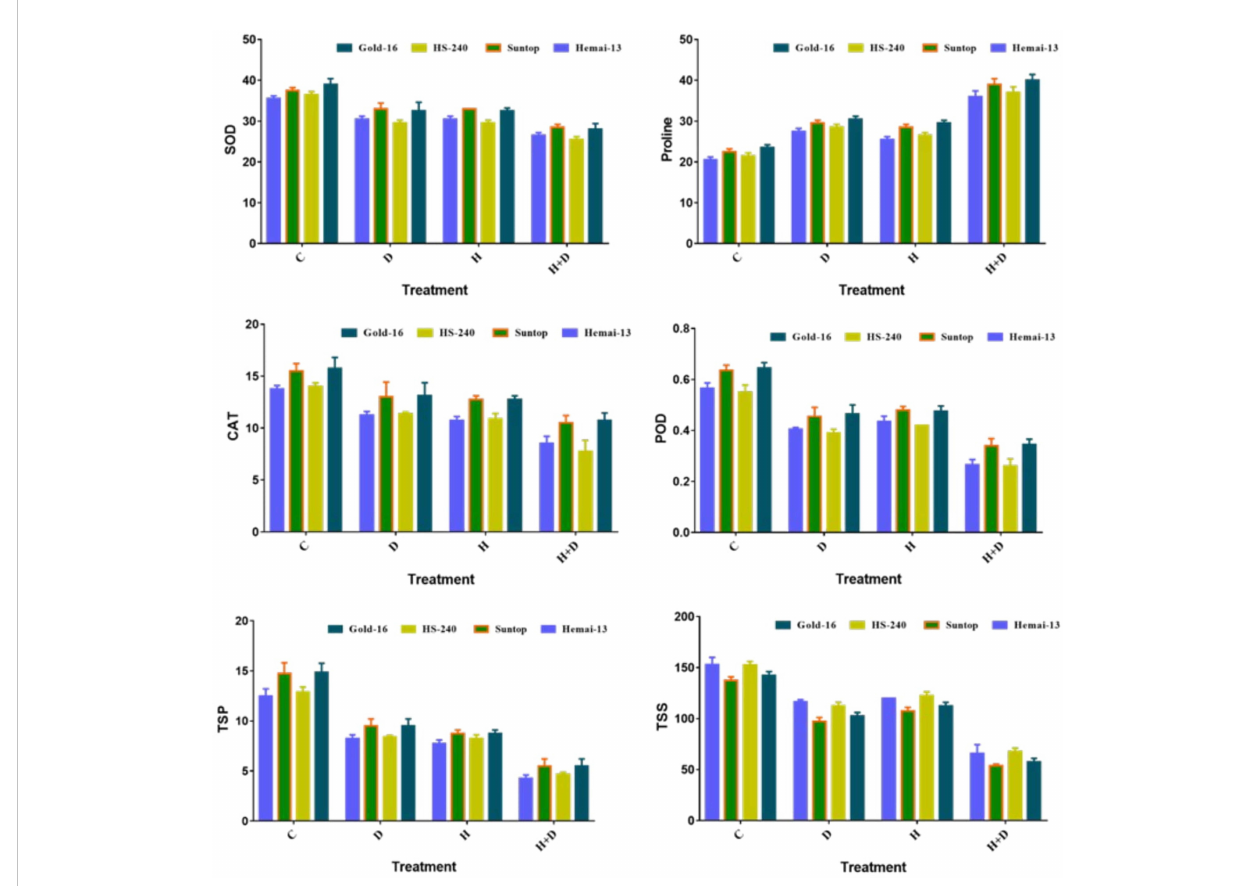
FIGURE 1 Variation in biochemical contents of wheat cultivars due to individual and combined treatments of drought and heat stress. Dry weight (DW); fresh weight (FW); superoxide dismutase (SOD); catalase (CAT); peroxidase (POD); total soluble proteins (TSPs); total soluble sugars (TSSs). Values in the graph are means averaged after every 4 days of treatment application during the two-factorial tri-replicate experiment at a p -value ≤ 0.05. *Units: POD, CAT, and CAT activities (enzyme units); proline ( m gg – 1 FW); TSP (mgg – 1 DW); TSS (mgg – 1